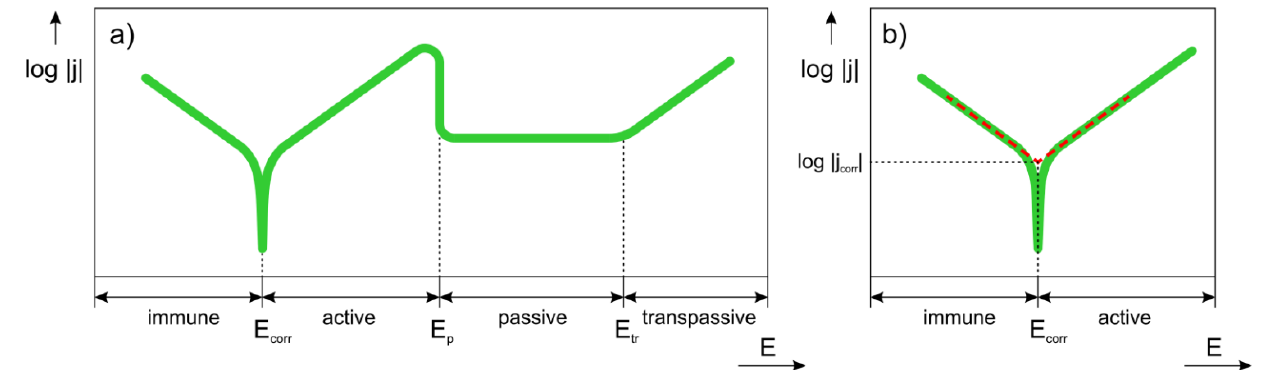
Figure 8. Schematic polarization curve of a passivating metal: ( a ) full curve, ( b ) Tafel extrapolation of cathodic and anodic regions.